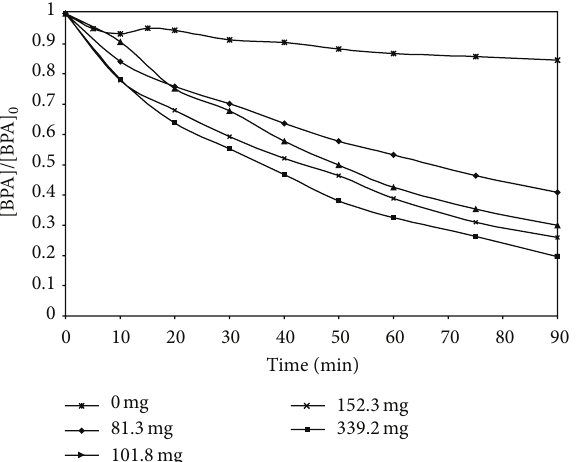
Figure 3: Effect of TiO 2 loading on the conversion of 100 𝜇 g/L BPA in UPW.